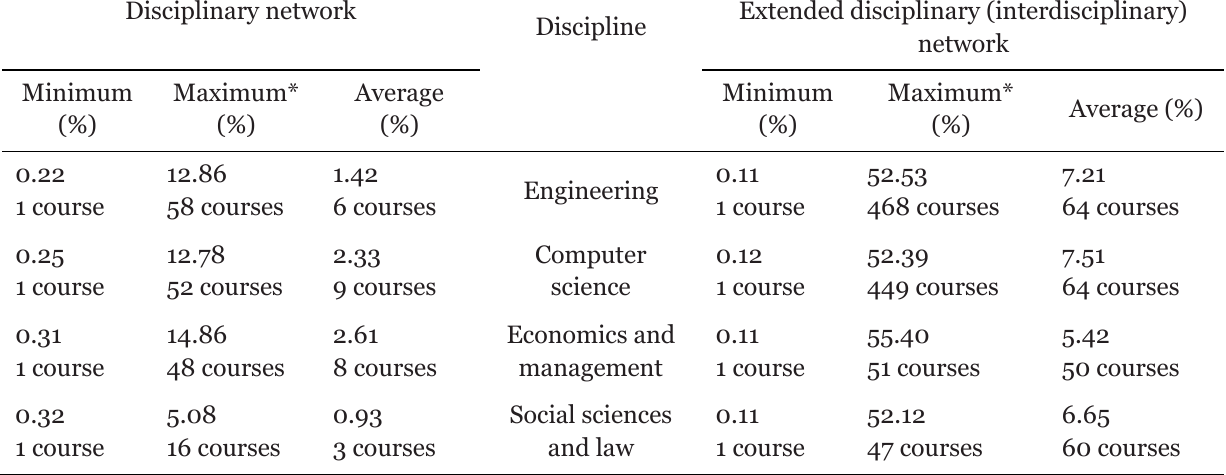
Results of Information Diffusion of Eight Interdisciplinary Networks Disciplinary network